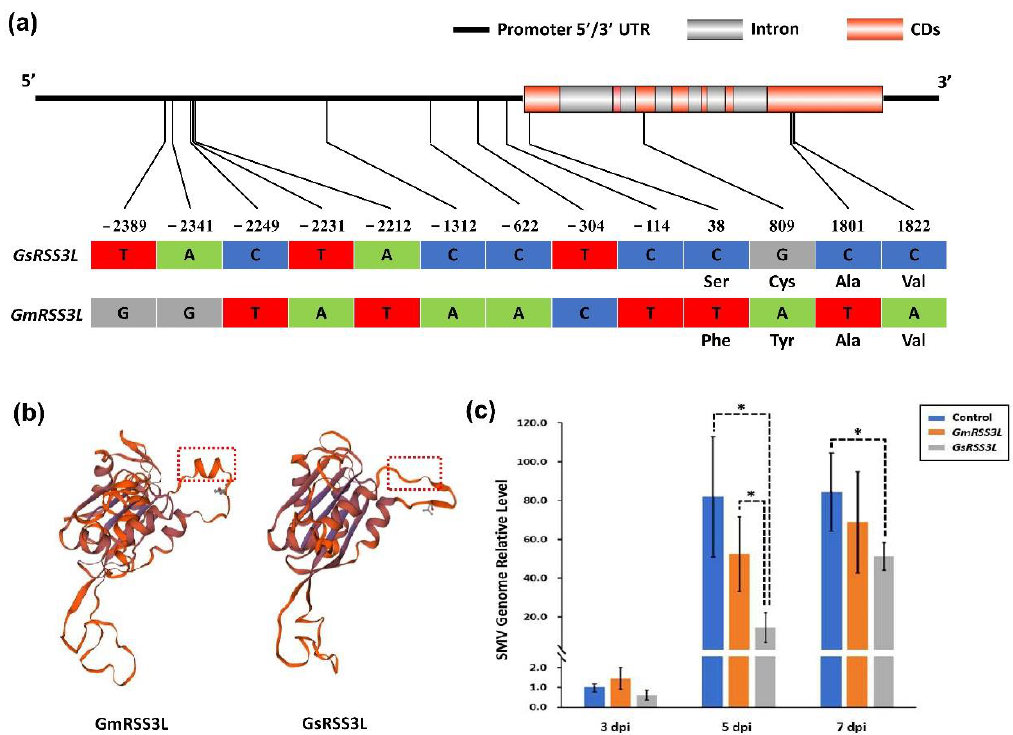
Figure 5. ( a ) Gene structures and single-nucleotide polymorphisms (SNPs) of GmRSS3L and GsRSS3L ; ( b ) predicted three-dimensional structures of protein GmRSS3L and GsRSS3L , as well as the α -helix region that may be affected by the two nonsynonymous mutants, as indicated by the red box; ( c ) qRT-PCR quantification of SMV genomic RNA in Nicotiana benthamiana leaves with transient expression of SMV infectious clone with GmRSS3L , GsRSS3L and empty vector of pCambia3301 as control, at 3, 5, 7 days post-inoculation (dpi). The * indicates a significant difference at p < 0.05.